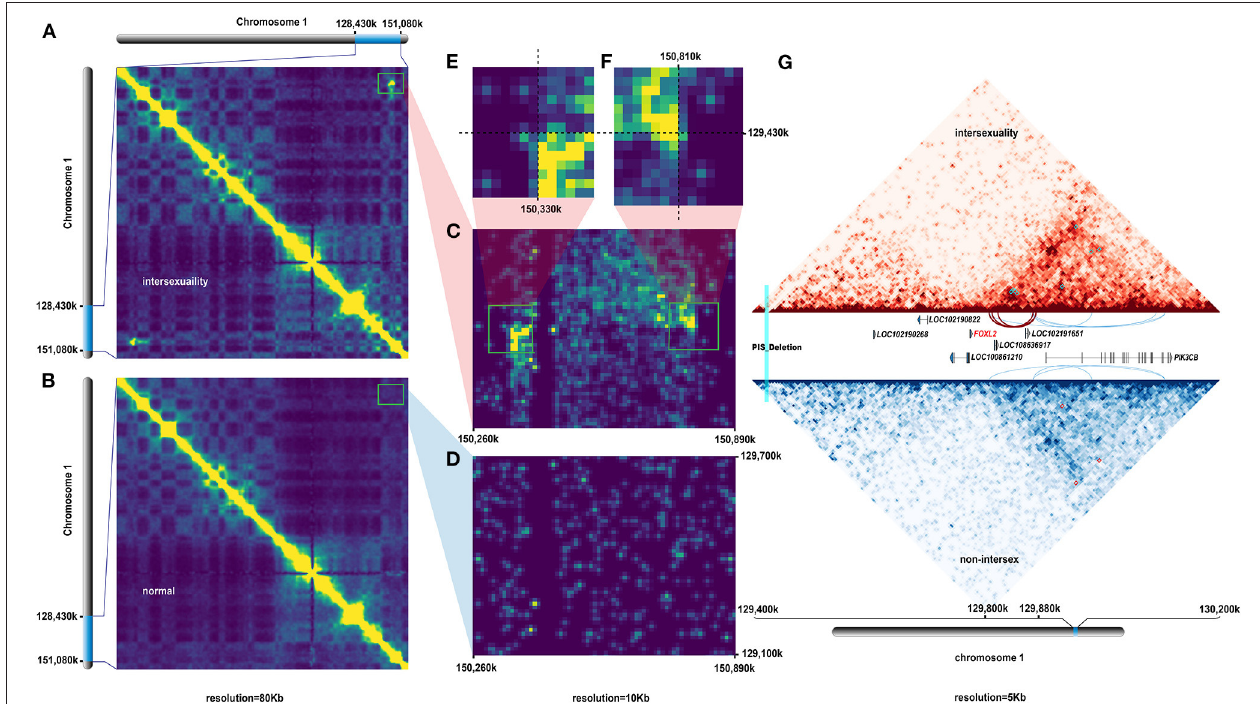
FIGURE 3 | Hi-C analysis results. (A) Window interaction matrix on CHI1 from 128.43 to 151.08Mb in intersexuality individuals with 80Kb resolution. (B) Window interaction matrix on CHI1 from 128.43 to 151.08Mb in normal control individuals with 80Kb resolution. (C–F) Interaction matrix and comparison of the 129.1–129.7 and 150.3–150.9Mb regions on CHI1 between intersexuality and normal individuals with 10Kb resolution. (G) Analysis of loop conformation in the 129.4–130.2Mb region of CHI1 between intersexuality and normal individuals at 5kb resolution revealed that the intersexuality case had a particular loop conformation in the 129.80–129.88Mb region at which the sexual development-associated gene FOXL2 was located 30Kb upstream.